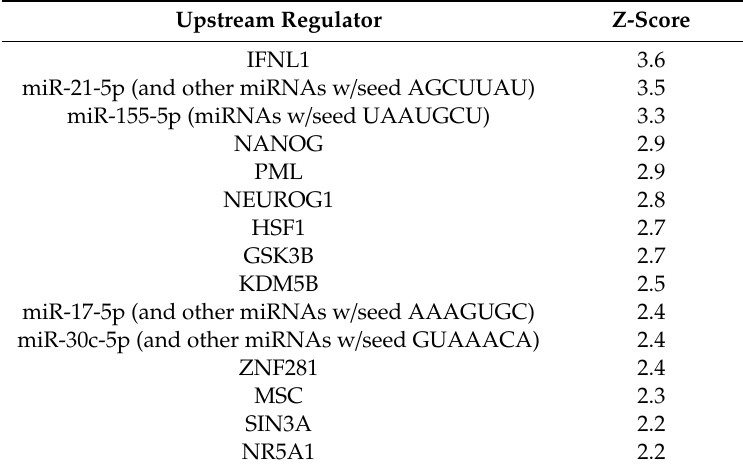
Table 4. Top 15 activated upstream regulators detected in the EBV-high sample by the Ingenuity pathway analysis (ranked by